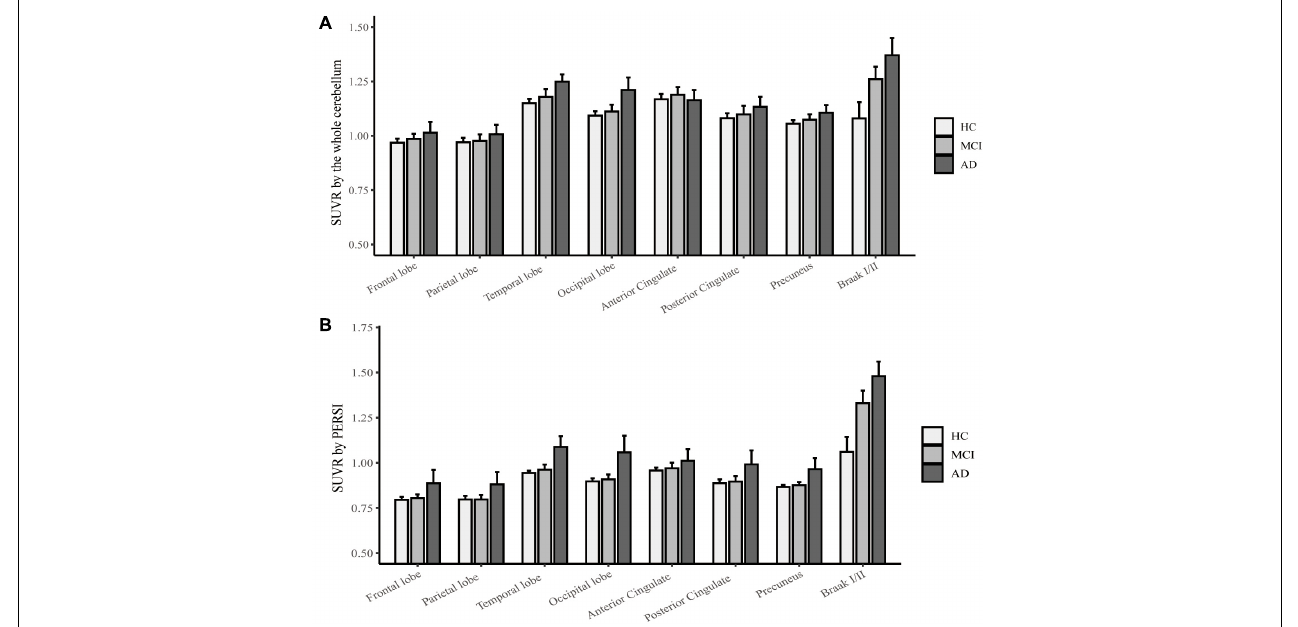
FIGURE 1 | Regional flortaucipir SUVR count normalization. (A) The whole cerebellum was the reference region for quantification. (B) PERSI-WM for HC, MCI, and AD groups. Mean group SUVRs ( ± SD) across predefined ROIs are shown. PERSI-WM has better diagnostic performance for dementia than the traditional method of using the cerebellum as the reference region.